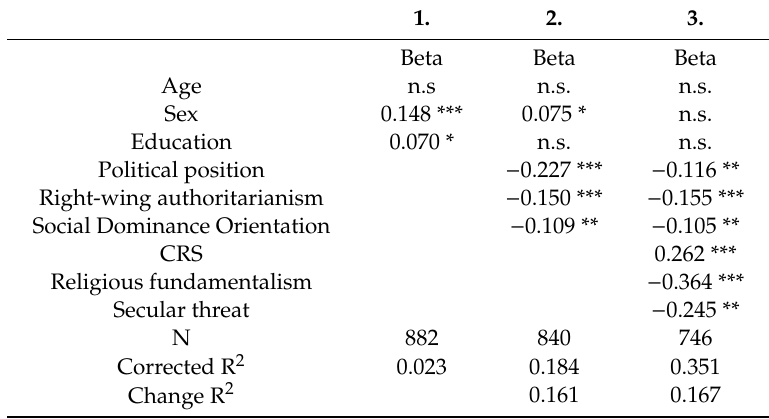
Table 1. Factors that influence attitudes towards Islam (regression analysis, listwise deletion). Source: XENO (2018); only non-Muslim respondents, own